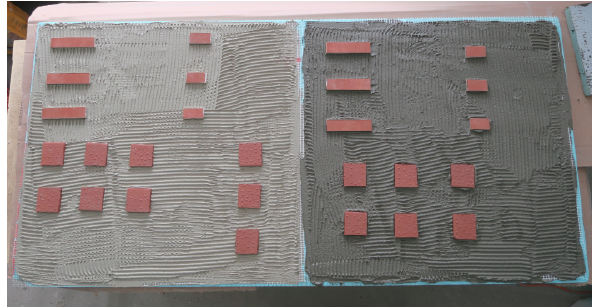
Figure 2: An example of a research stand, for adhesion measure- ments, using the pull-off method and shear strength tests, by